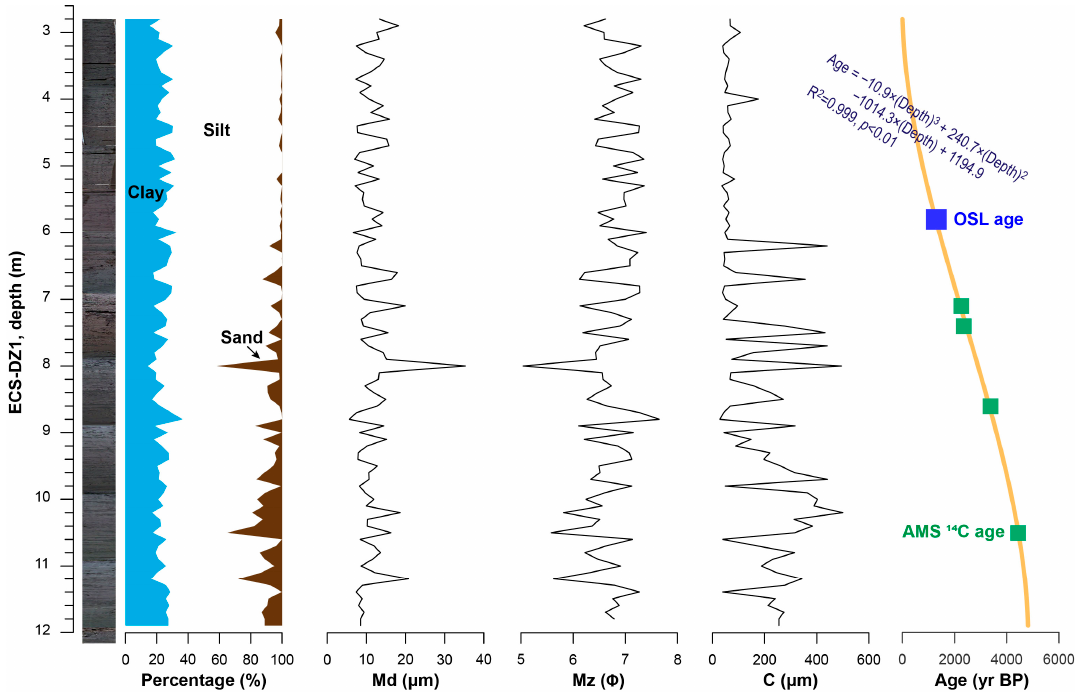
Figure 2. Core photos and profile of core ECS-DZ1 about component percentages of clay (<4 μ m), silt (4–63 μ m), and sand (>63 μ m), median size (Md), mean size (Mz), C value (the one percentile of grain size distribution), and AMS 14C dating results with an age-depth